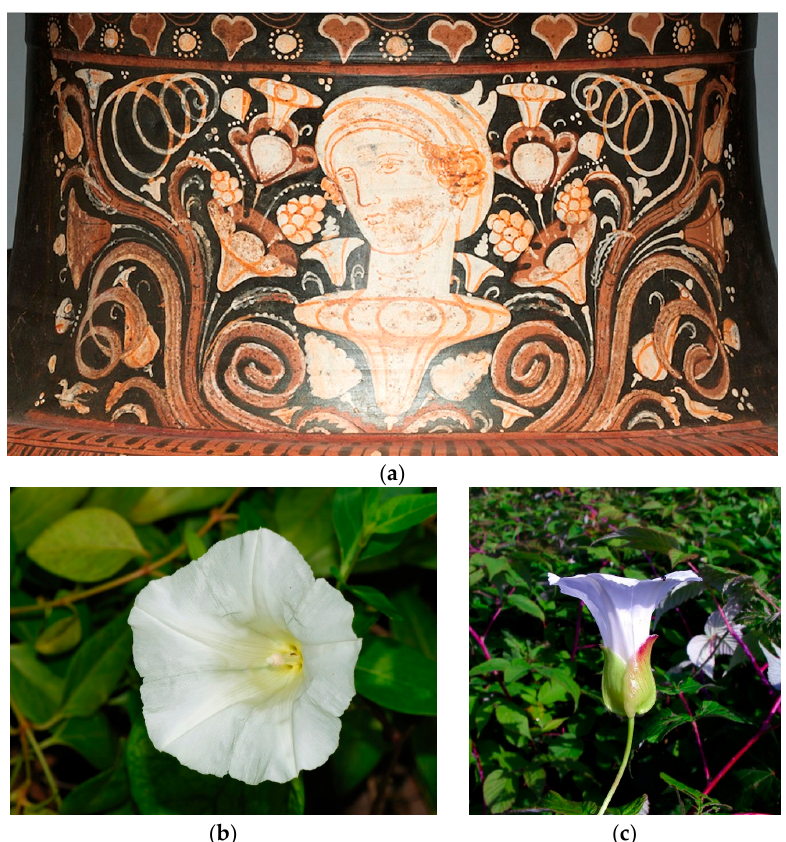
Figure 24. New York, Metropolitan Museum of Art 25.78.30 Upper portion of the Attic marble stele of Kallidemos topped by a double palmette flanked by two half-palmettes, all rising from spiral tendrils emerging from an acanthus calyx, ca. 350–325 B.C. Image © The Metropolitan Museum of Art.